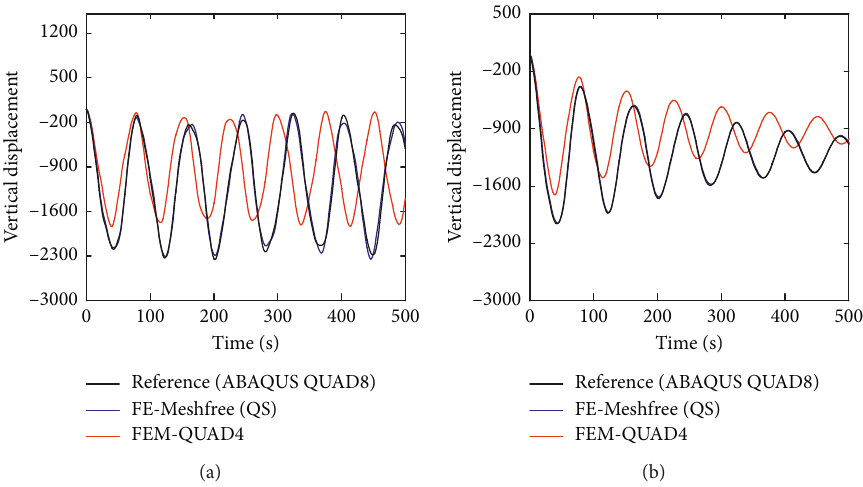
Figure 33: Transient response of spherical shell subjected to constant step loading: (a) without damping; (b) with